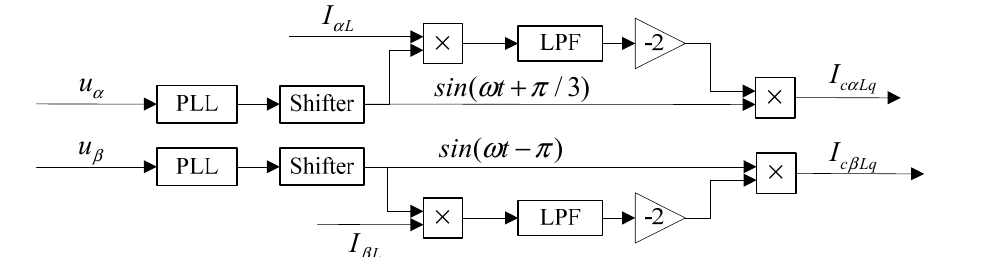
Figure 6. Load reactive power dynamic compensation.